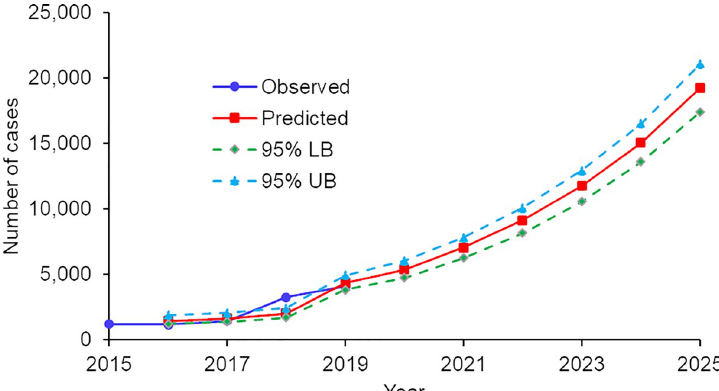
Fig 7. Observed vs. model-predicted total cases from 2015 to